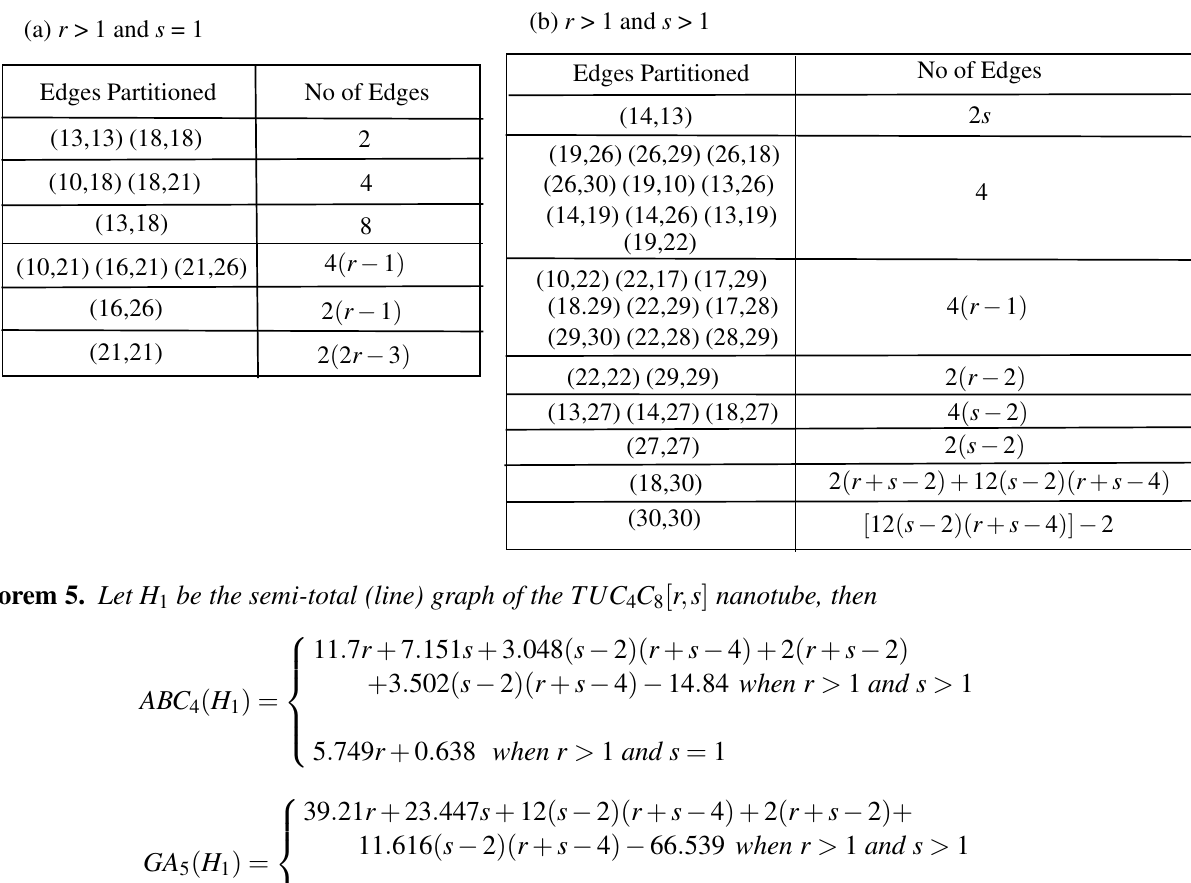
Table 5: Semi-total(line) graph of Nanotube for Neighborhood